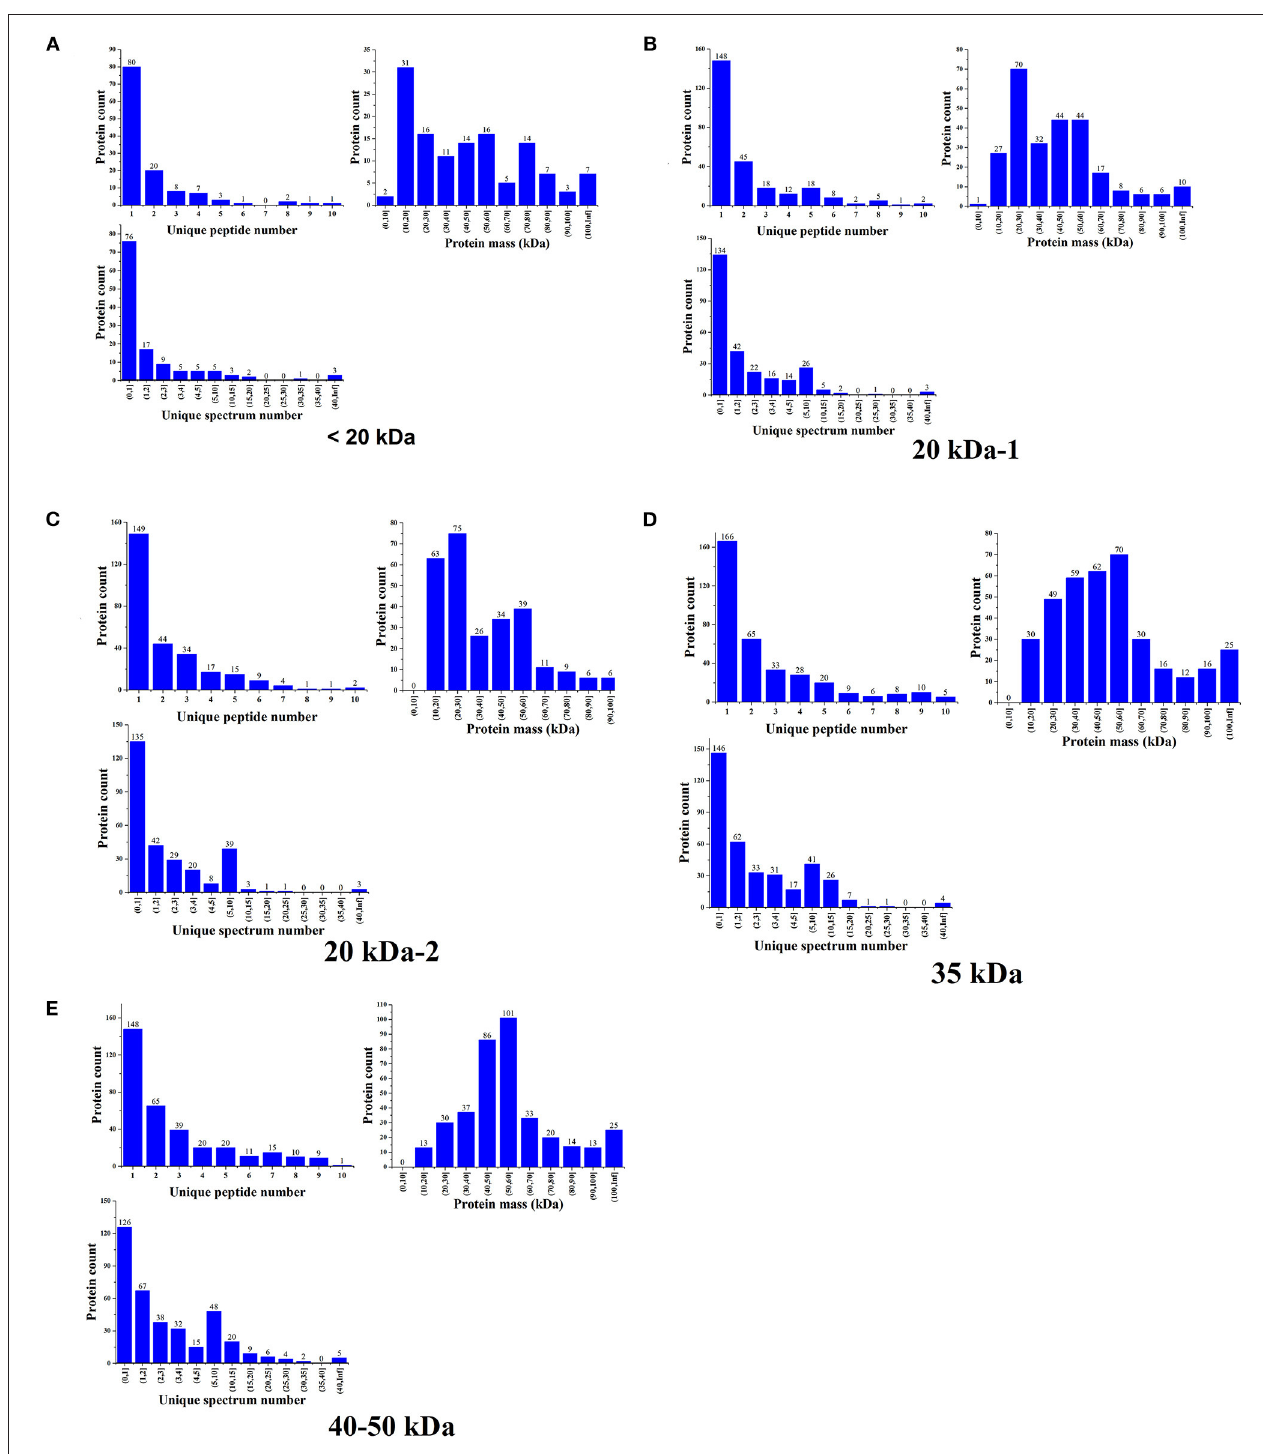
FIGURE 3 | Basic statistical charts for the protein identifications. (A) Identification results for proteins in the 40–50 kDa range. (B) Identification results for proteins in the 30–40 kDa range. (C,D) Identification results for proteins in the 20 kDa range. (E) Identification results for proteins in the < 20 kDa range. while Glu was the most abundant amino acid in Gly7S. The His one conserved cysteine residue, although it had four NXT content in Cs7S was significantly lower than that in the soybean glycosylation sites. The amino acid composition analysis revealed protein. The E/T values of Cs7S (43.5%) and Gly7S (44.5%) that Leu was the most abundant amino acid in the Cs7S protein,